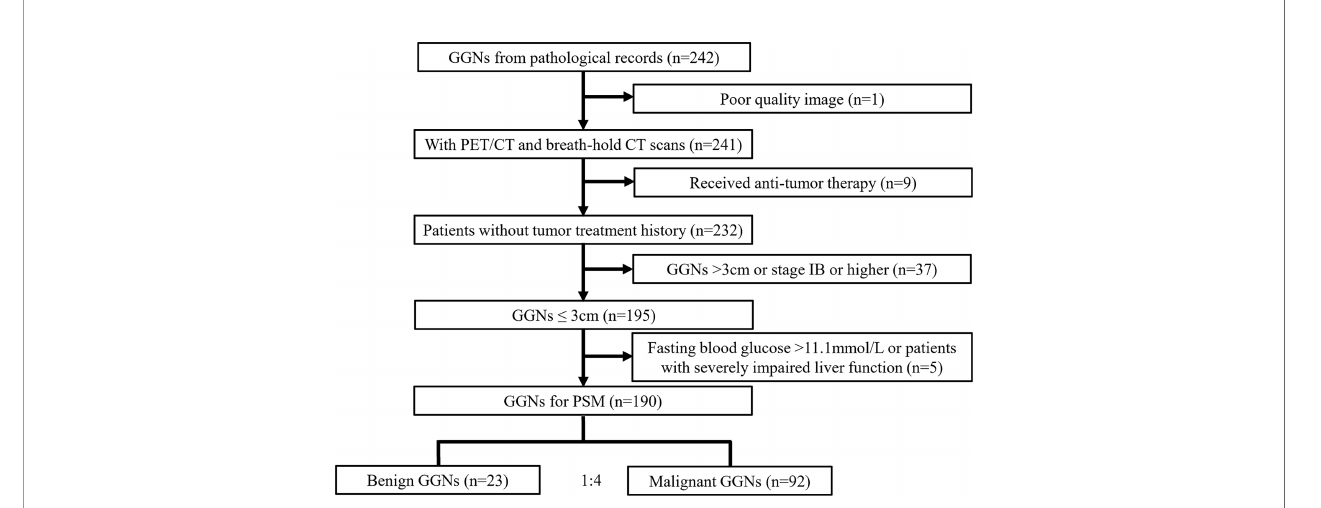
FIGURE 1 | Flow chart of the study. GGN = ground-glass nodule, PSM = propensity score